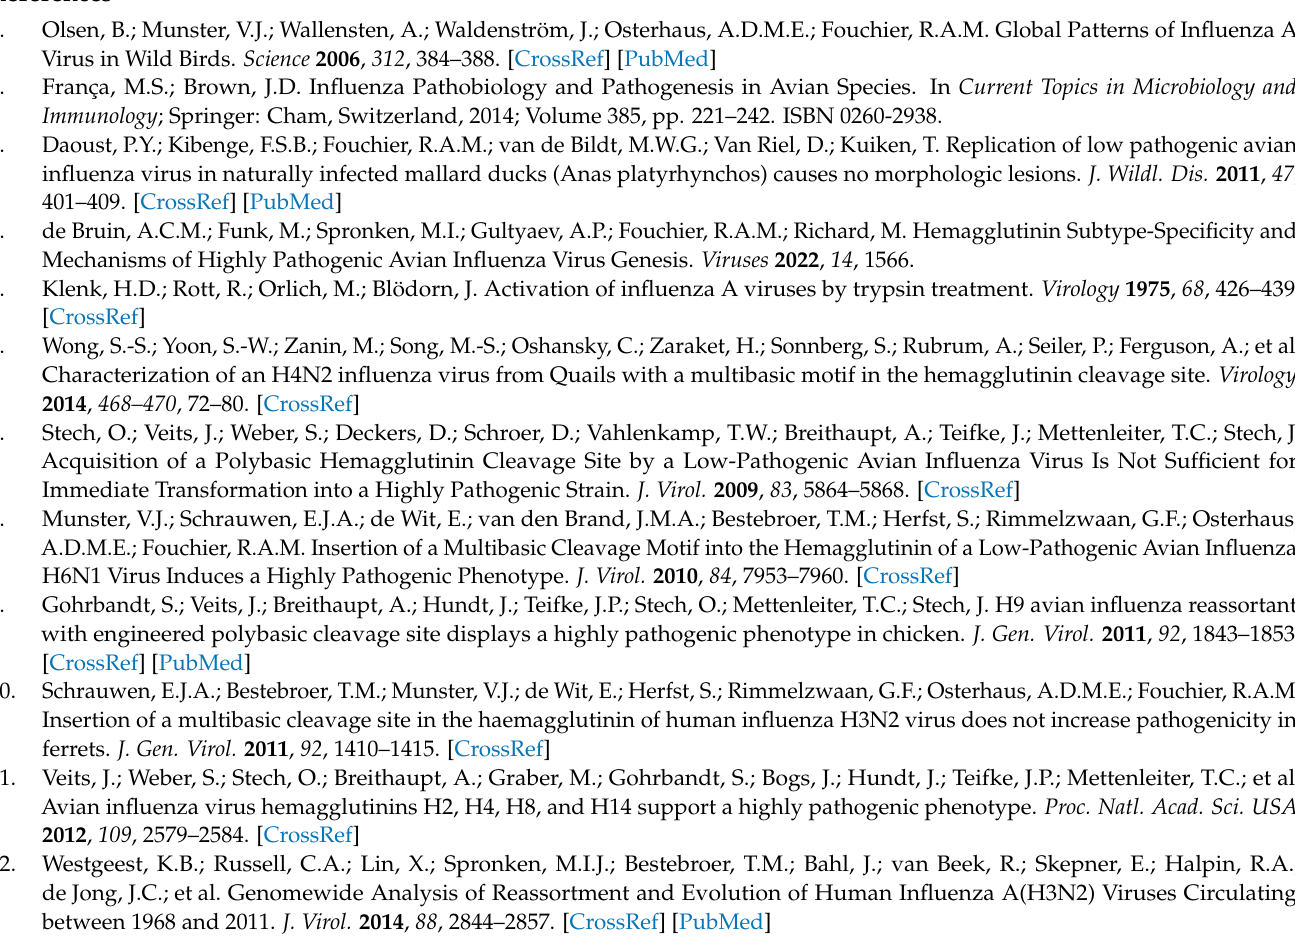
Figure S3: Analyses broken down by virus species and/or region of isolation; Supplementary File 3: Table S1: Frequency of unique LPAIV cleavage site motifs; Table S2: Species distribution of